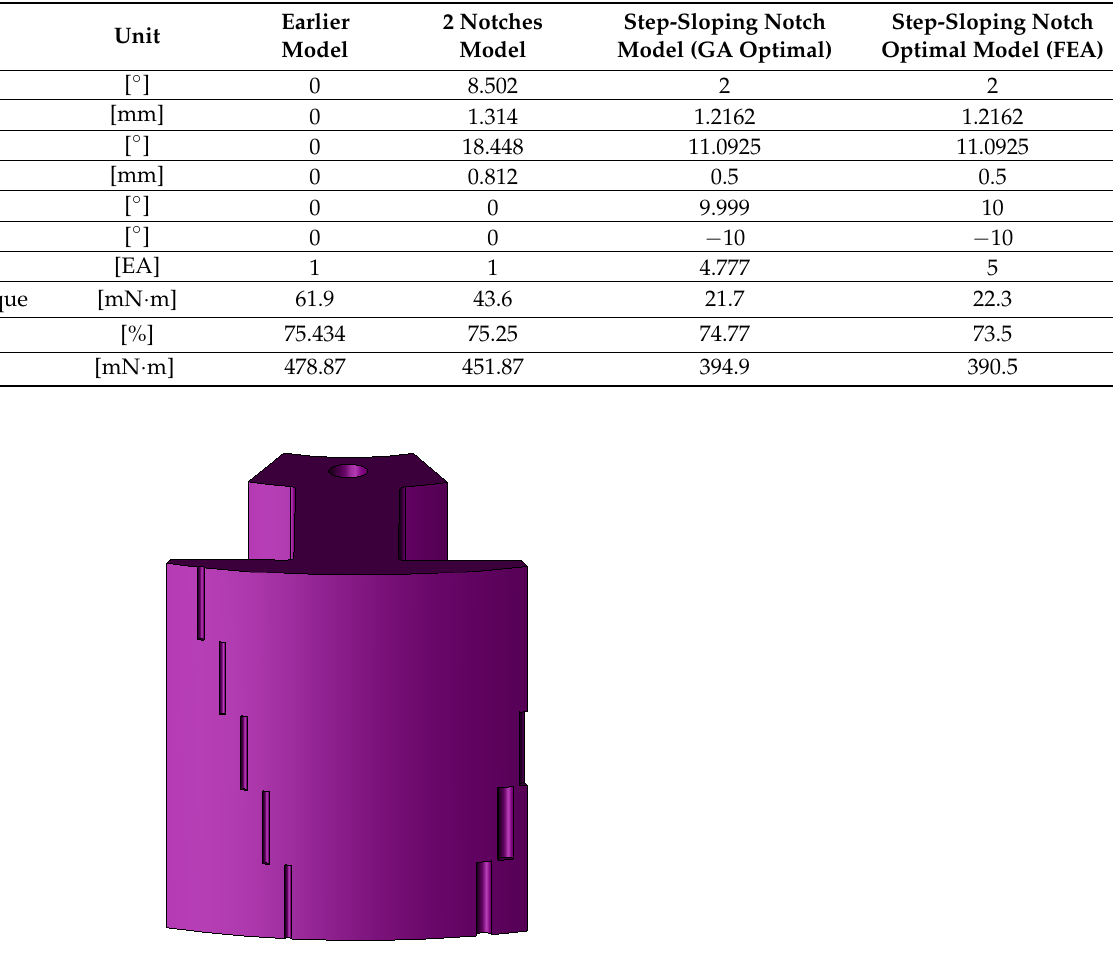
Figure 9. Optimal design model applied step-sloping notch.